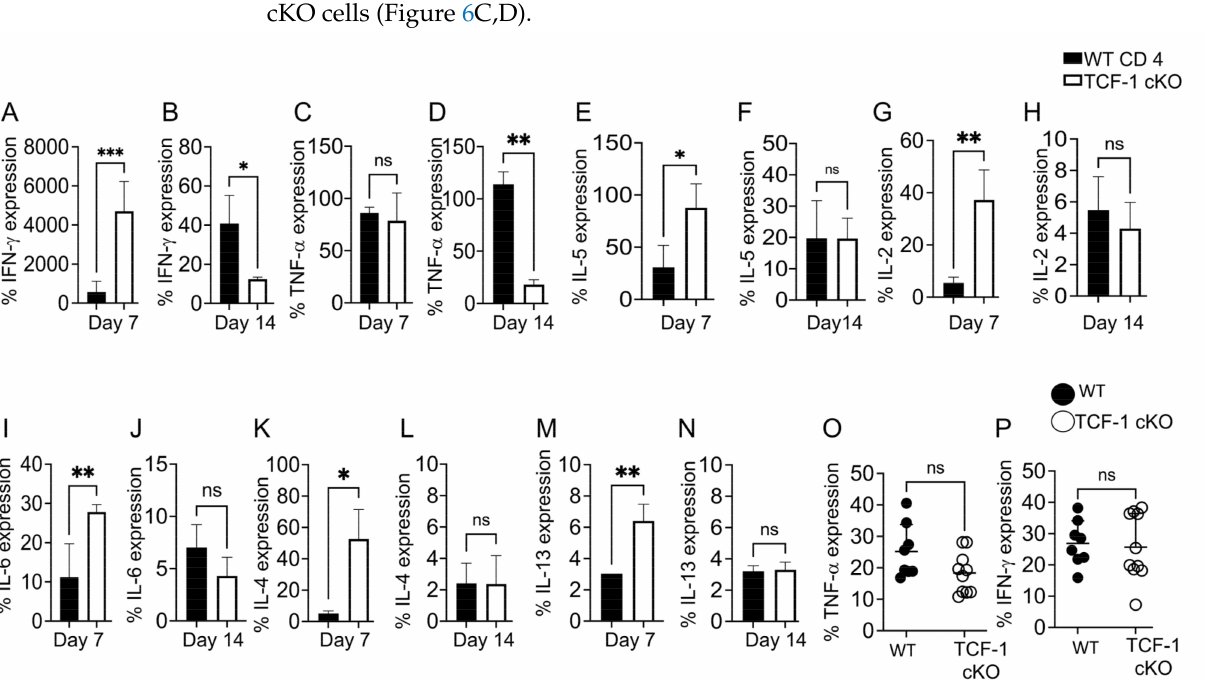
Figure 7. TCF-1 regulates serum levels of cytokines during alloimmunity. Recipient BALB/c